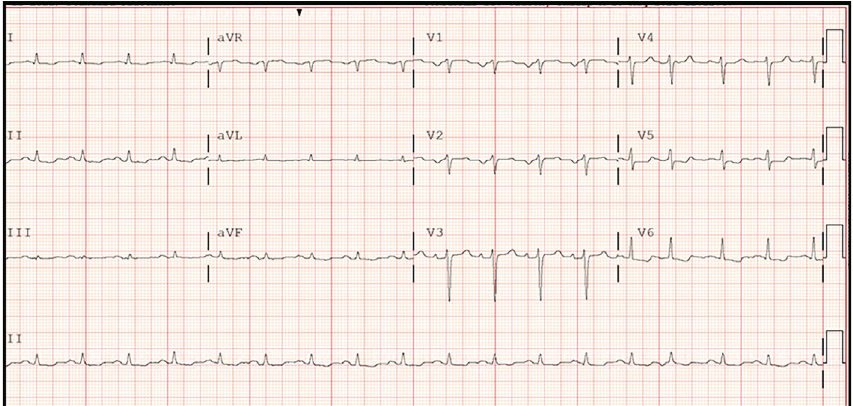
Figure 1: ECG showed sinus rhythm with low voltage in the limb leads.